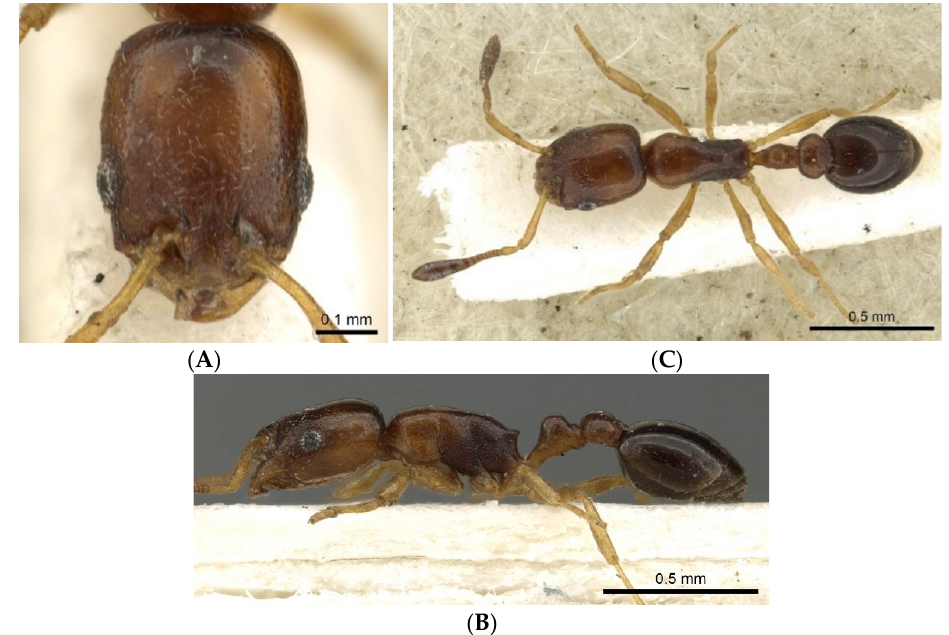
Figure 8. Cardiocondyla britteni, holotype (specimen CASENT0901496 from www.antweb.org, photo Ryan Perry): head in dorsal view ( A ), lateral view ( B ), dorsal view ( C ).